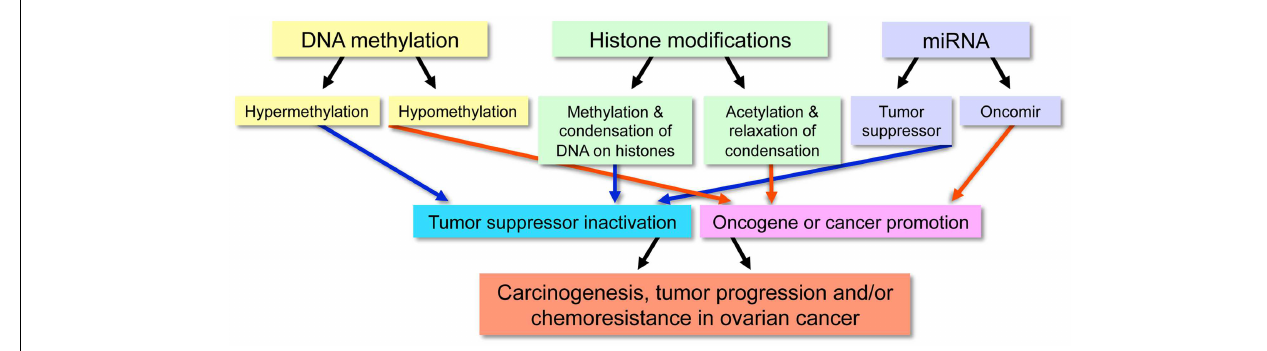
FIGURE 1 | Outline of the functional effect resulting from specific epigenetic modifications in malignancy .